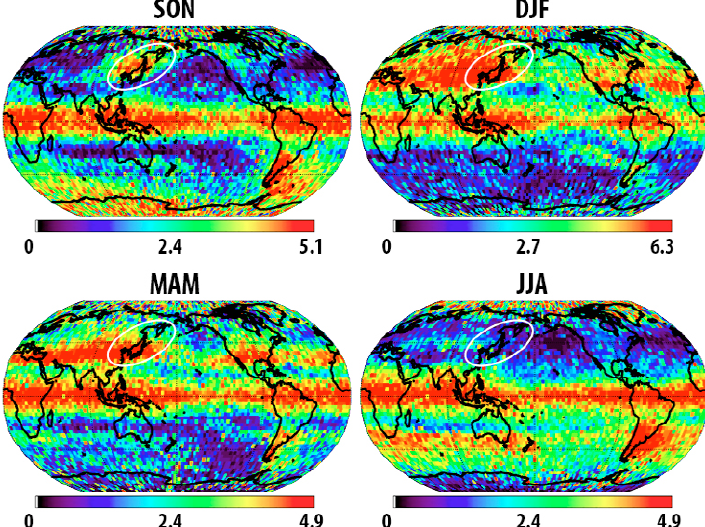
Figure 4. Seasonal means of the potential energy in Jkg − 1 averaged across the whole vertical profile for 2007–2010 (non-linear colour scale used).